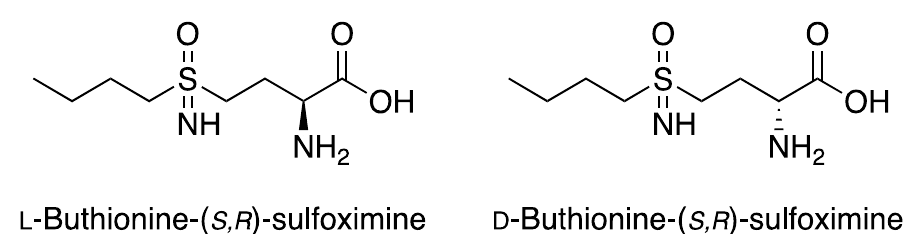
Figure 1. Chemical structure of buthionine sulfoximine isomers.